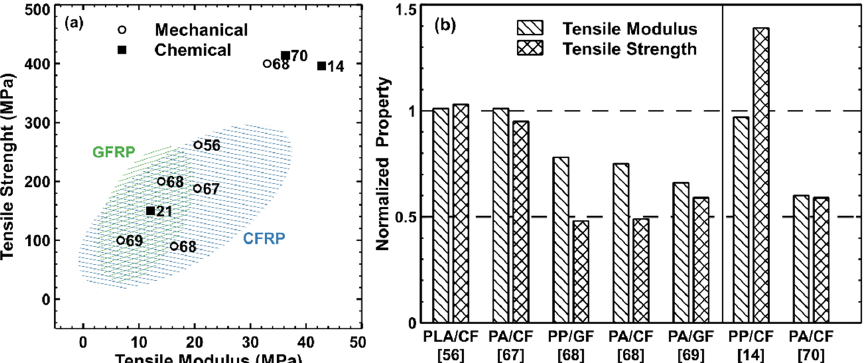
Figure 1. ( a ) Values of tensile strength against tensile modulus of the reviewed recycled composites. The green and blue dashed areas contain the typical values for thermoplastic GFRPs and CFRPs. ( b ) Values of tensile modulus and strength displayed by the recycled composites, normalized against the values of the virgin composites. The solid vertical line separates the values of mechanically recycled composites (left side) from the ones of chemically recycled composites.